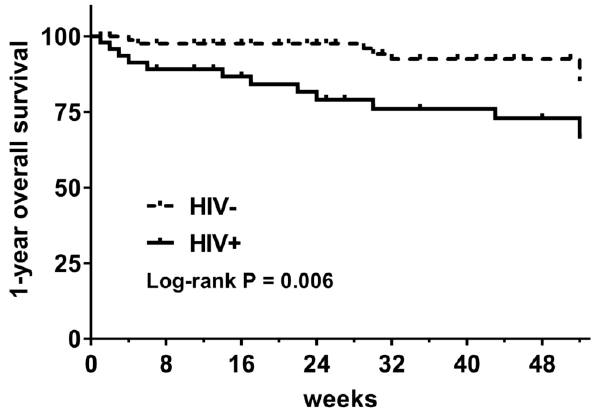
Figure 2. One-year overall survival of DLBCL patients with and without HIV infection. (HIV − : HIV-uninfected patients; HIV+: HIV-infected